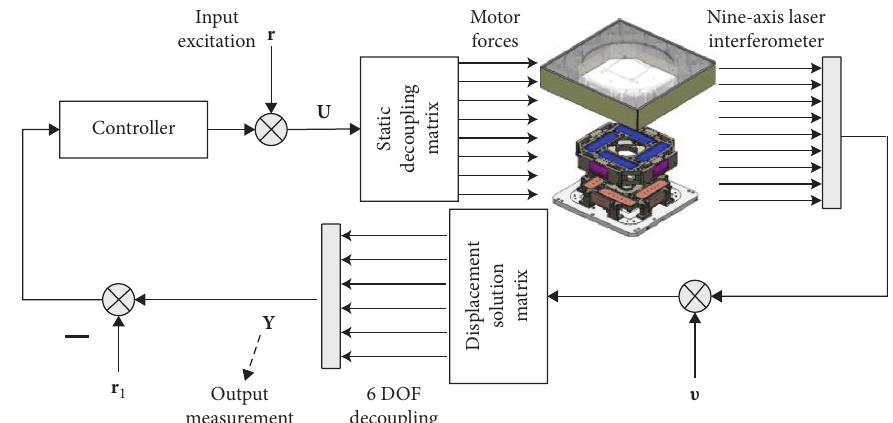
Figure 3: The block diagram of closed-loop subspace